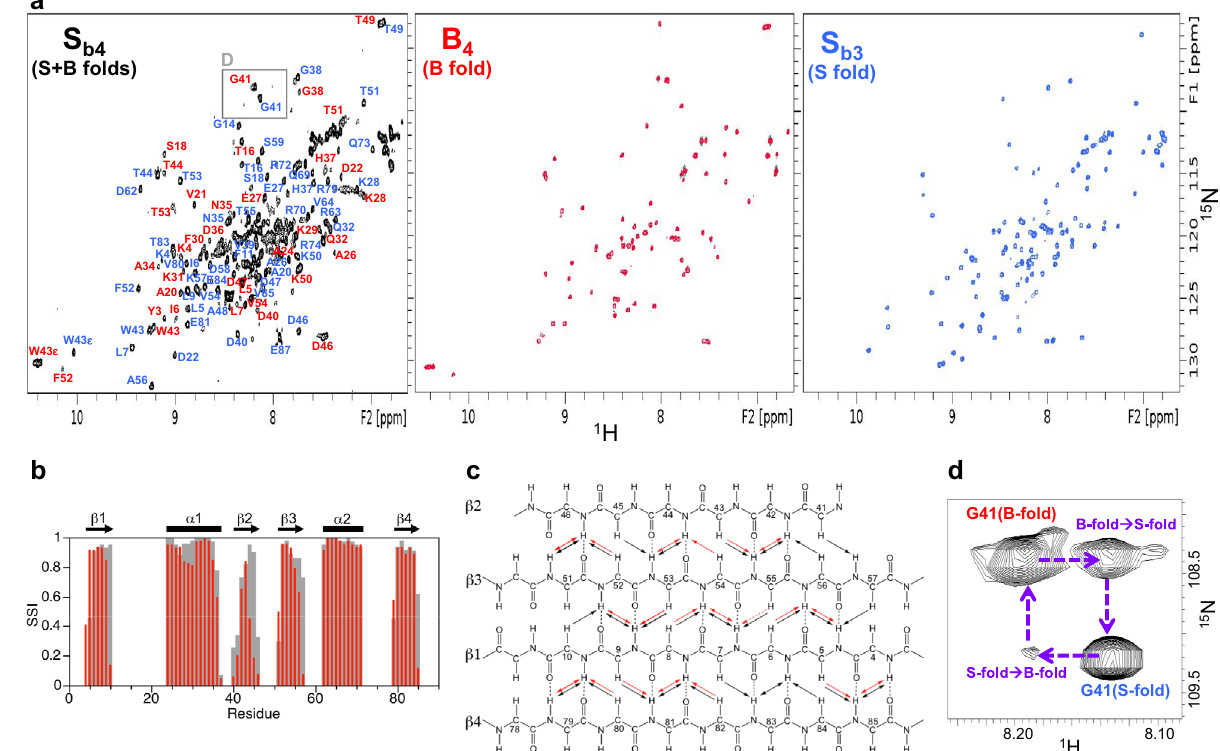
Fig.7|S b4 isanequilibriummixtureofS-andB-states.a Two-dimensional 1 H – 15 N HSQC spectraofS b4 (left),B 4 (center), and S b3 (right) at25°C. Inthe S b4 spectrum, backbone amide resonance assignments are shown for the S-state (blue) and the B-state (red). b Con fi dence levels of ordered secondary structure regions for the S-state of S b4 at 30°C (red) and for S b3 at 25°C (gray) from chemical shifts using